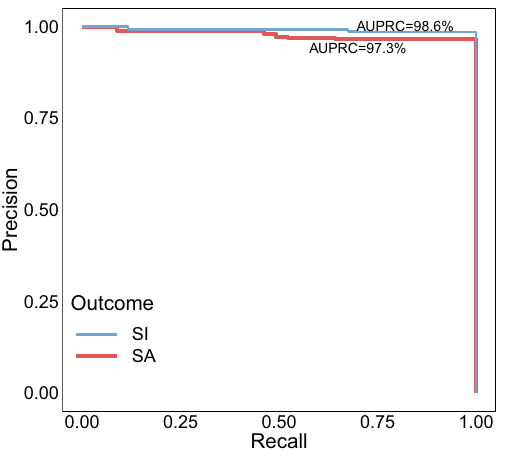
Figure 3. Precision-recall curves for suicidal ideation (SI) and suicide attempt (SA) evaluation of the top 200 highest ranked patients retrieved by the NLP system.